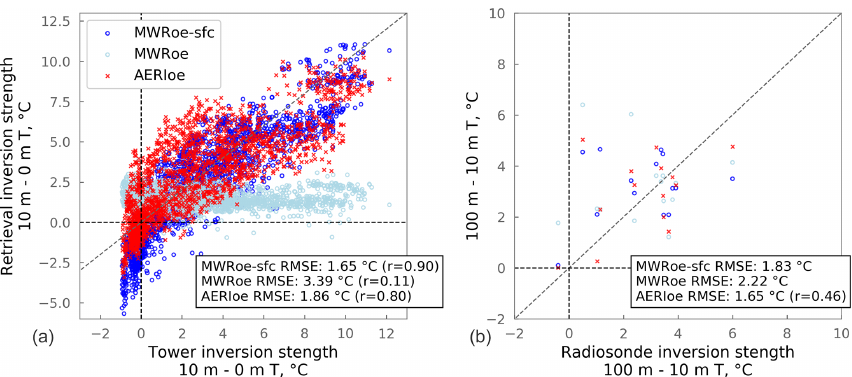
Figure 6. (a) Inversion strength (10–0m temperature, T ) retrieved from the AERIoe (red), the MWRoe (light blue), and the MWRoe-sfc (dark blue) versus observations from the tower-mounted HMP155 probes. (b) The same as (a) except for the 100–10m inversion strength compared to observations from 14 coincident radiosonde profiles. On both subplots, the diagonal grey dashed line represents perfect agreement, and the horizontal and vertical dashed black lines at 0 ◦ C delineate when a surface-based temperature inversion is present (right quadrants) versus absent (left quadrants). The root-mean-squared error (RMSE) values are included on the plots, and the Pearson’s correlation coefficients ( r ) are only included when they are significant at the 90% confidence level.